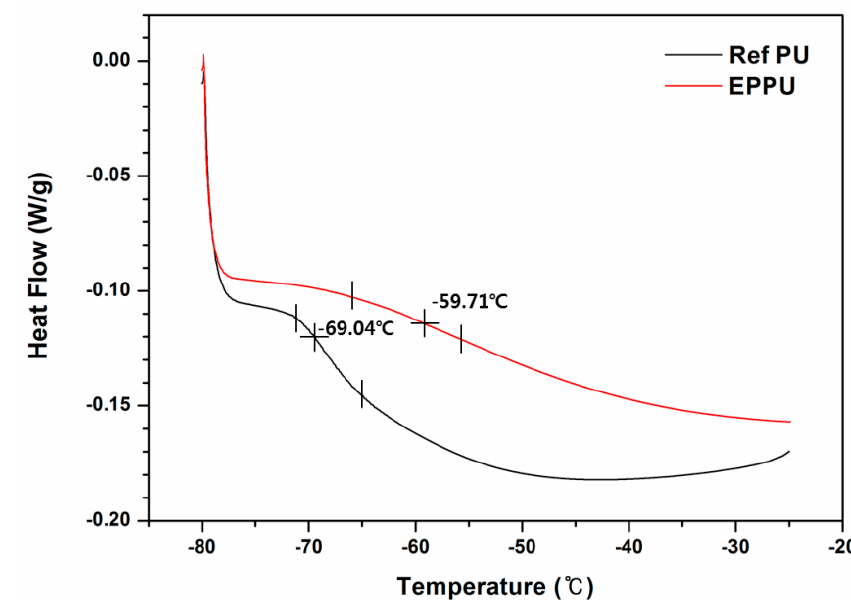
Figure 5. Differential scanning calorimetry (DSC) data for Ref PU and EPPU.